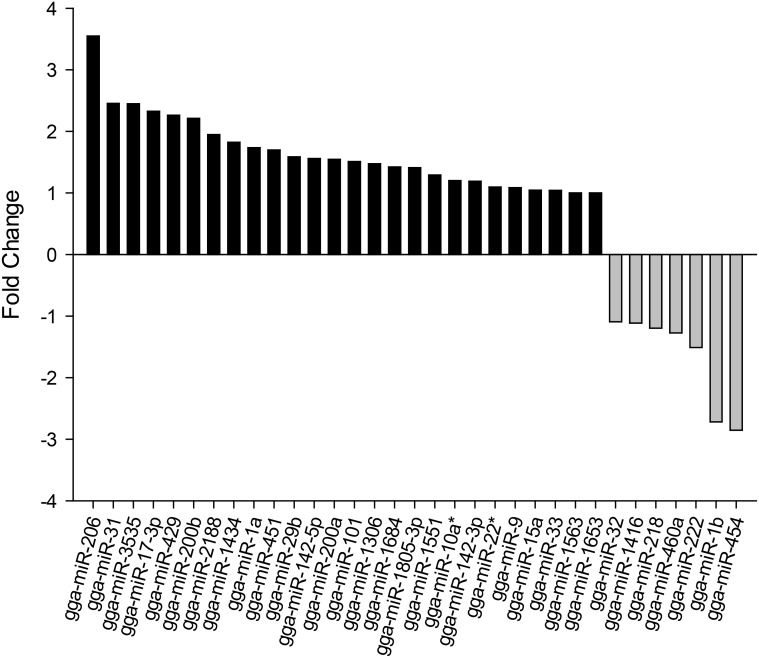
Differentially expressed miRNAs.26 up-regulated miRNAs, and 7 down-regulated miRNAs in the fat chicken line. Fold-change (Y-axis) indicates in log2-scale the fold-changes between the number of reads of miRNAs in the fat chicken lines and the lean chicken line.